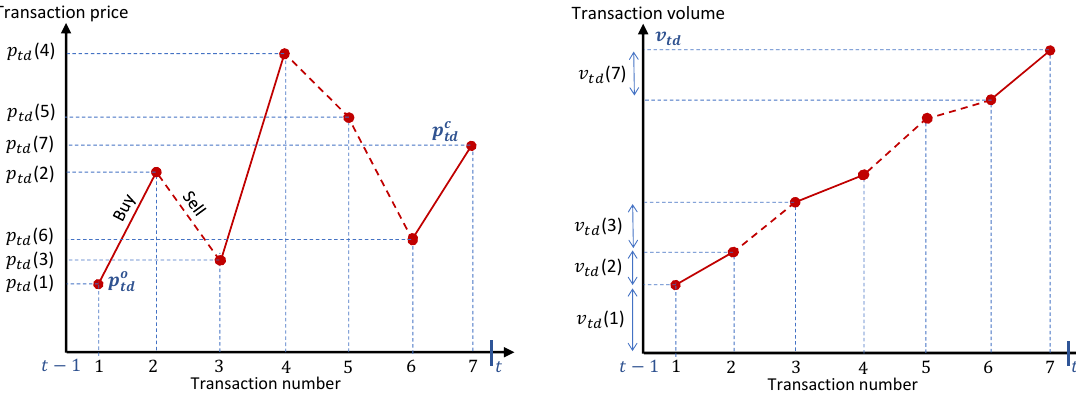
Figure 2. An illustration of input data for trade impact estimation in time slot t on day d .